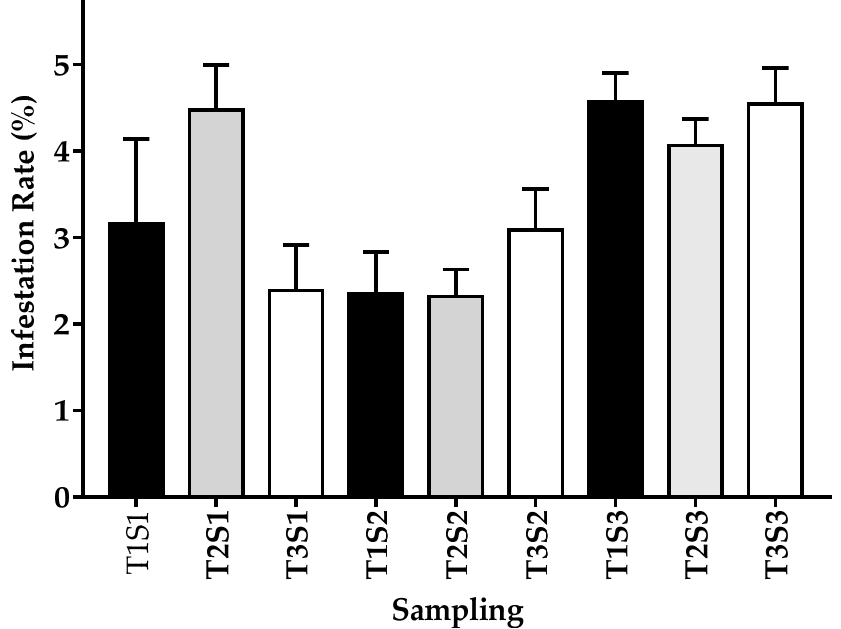
Figure 2. Infestation by Varroa destructor in each evaluation period and at different altitude tiers in the central highlands of Ecuador. Samples were collected in March–April (before honey production, S1), May–July (during production, S2), and August–September (after production, S3). The data was divided into three altitude tiers 2600–2800 [T1], 2801–3000 [T2] and higher than 3000 [T3] meters above sea level (m.a.s.l). Data represent means ± SEM (hives/sampling: T1 n = 15, T2 n = 35, T3 n = 25). ANOVA analysis indicated lack of significant differences between groups.